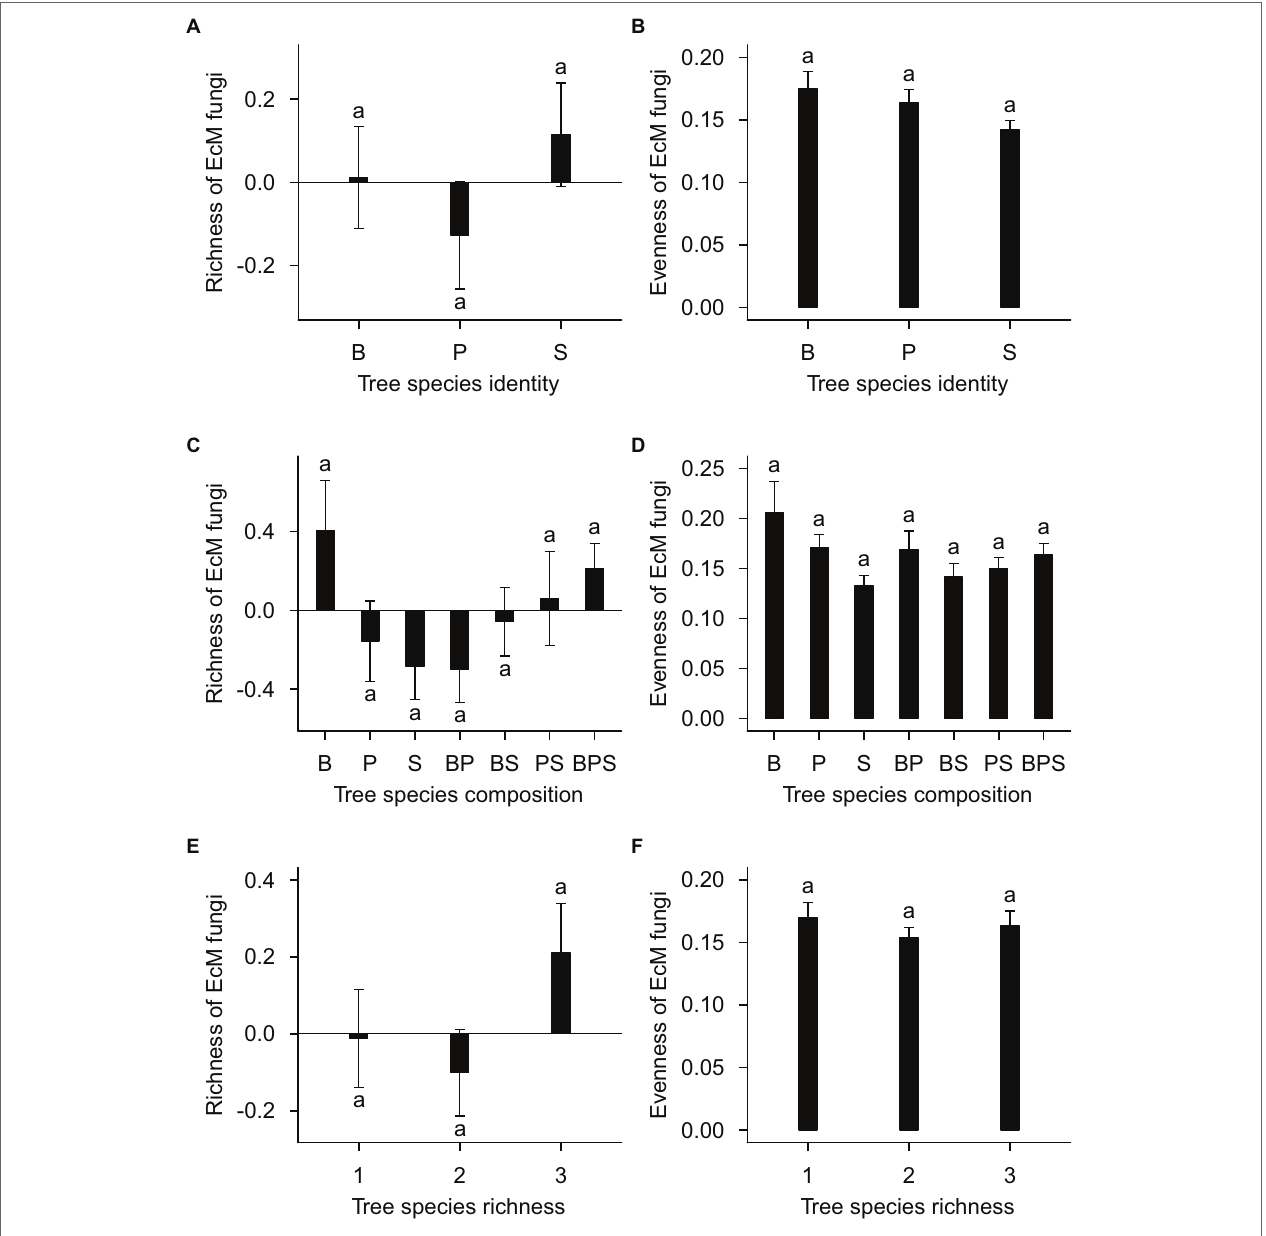
FIGURE 3 | (A) Tree species identity, (C) tree species composition, and (E) tree species richness effects on richness of EcM fungi. (B) Tree species identity, (D) tree species composition, and (F) tree species richness effect on evenness of EcM fungi. EcM fungal richness estimation is based on standardized residuals. Data represent the means of all samples with SEs. Different letters denote significant differences ( p < 0.05) among factor levels. B, birch; P, pine; S, spruce; BP, birch- pine; BS, birch-spruce; PS, pine-spruce; BPS, birch-pine-spruce; 1, monospecific; 2, two-species mixtures; and 3, three-species